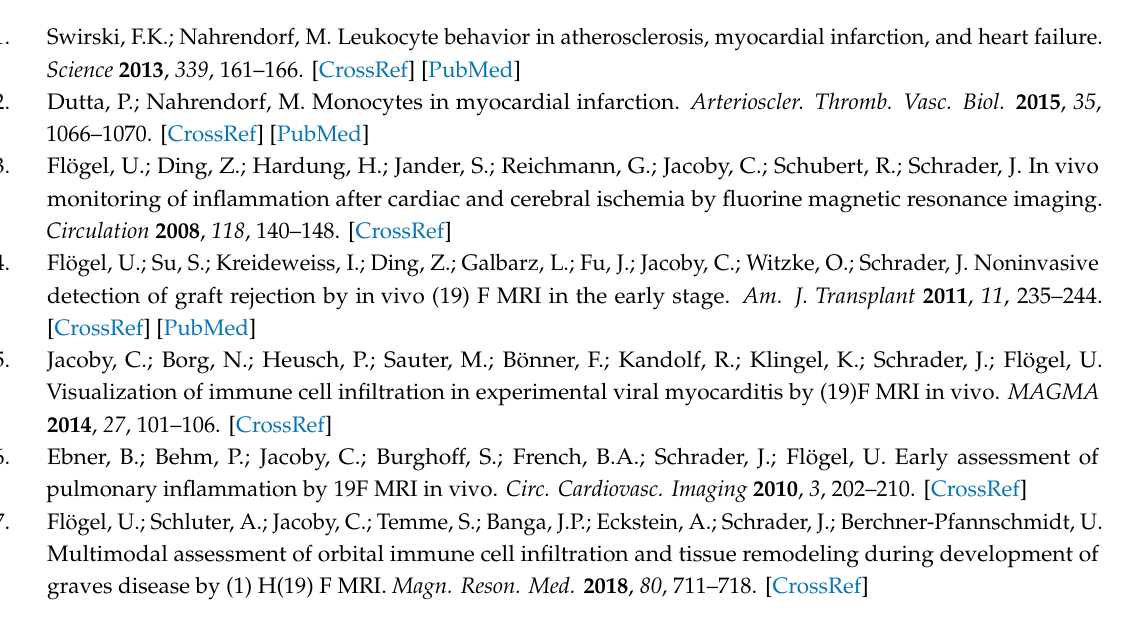
Figure S1: Monocyte Gating Strategy, Figure S2: Neutrophils gating strategy, Figure S3: Lymphocyte Gating Strategy, Figure S4: Apoptosis / Necrosis Gating Strategy, Table S1: Inclusion and exclusion criteria, Table S2: Patients characteristics, Table S3: Univariate correlation analysis of several clinical parameters to 6-FAM MFI after 160 min of PFOB-NE